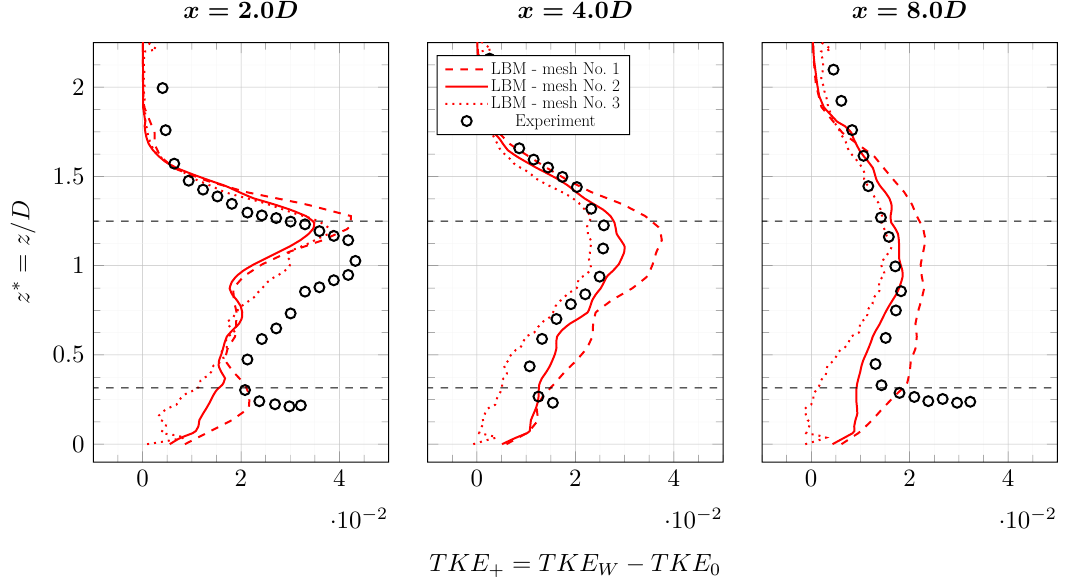
Figure 10. Average axial TKE z profiles in the wake of the tidal turbine [27] at TSR = 1.1: experimental data and ALM-LBM results for the three meshes. Turbine footprint is drawn in horizontal black